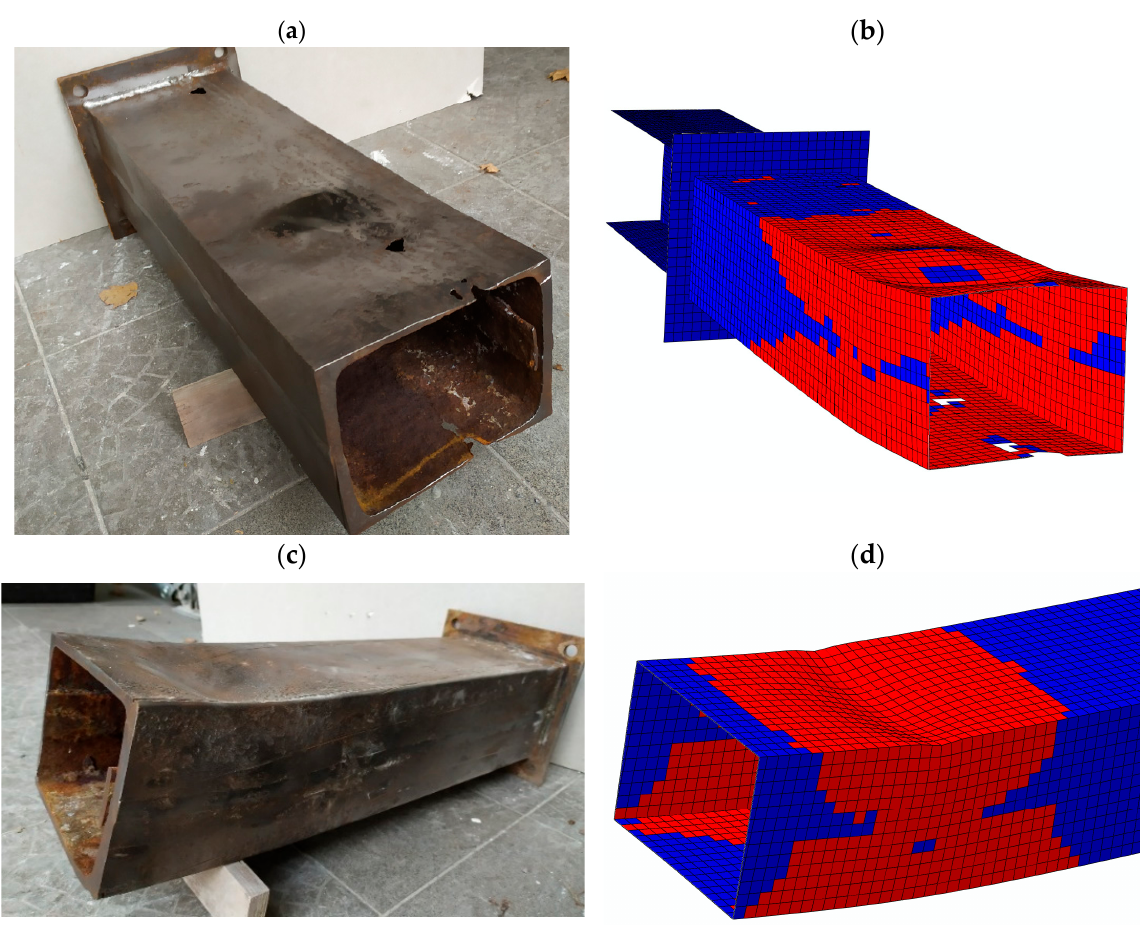
Figure 12. Failure mode views after destruction: ( a ) G5 sample; ( c ) G3 sample. Distribution of the yield elements at the maximum bending moment: ( b ) G5 bending simulation; ( d ) G3 bending simulation.